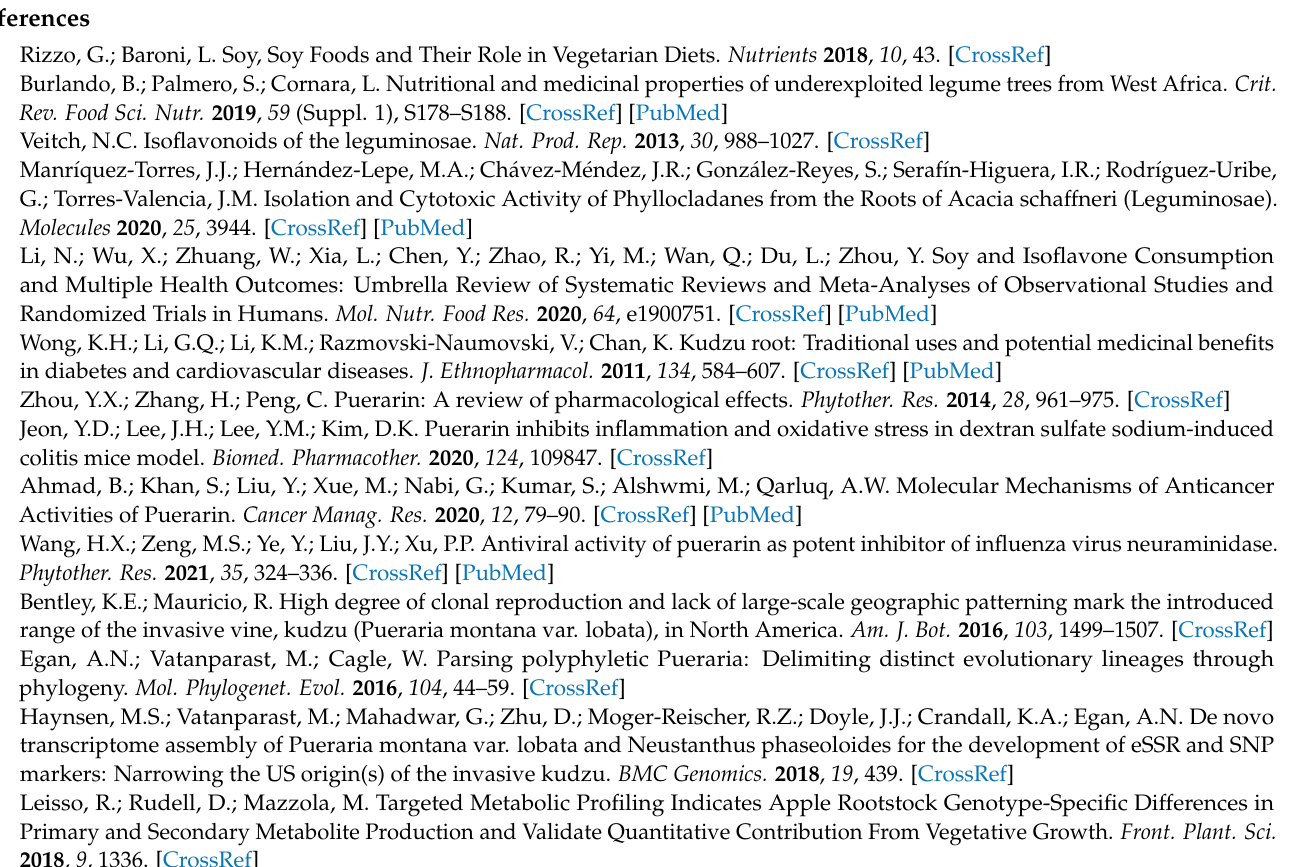
Supplementary Materials: Figure S1: Differentially accumulating metabolites between HNMV and LNMV group, Figure S2: Metabolic pathways enrichment analysis for HNMV and LNMV group differentially accumulated metabolites, Figure S3: Total ion chromatogram (TIC) of each samples, Table S1: Widely targeted UPLC-MS/MS based metabolite profiling of P. lobata, P. lobata var. thomsonii and P. lobata var. montana, Table S2: Statistics of differentially metabolites in the root tuber between HNMV group and LNMV group, Table S3: Statistics of up-regulated metabolites in the root tuber between HNMV group and LNMV group, Table S4: Statistics of differentially metabolites in the root tuber between P. lobata and P. lobata var. thomsonii, Table S5: The retention time data of 30 representative